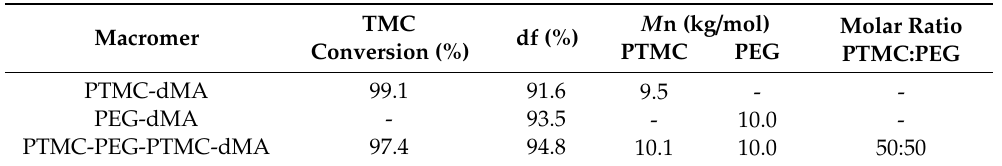
Table 1. Macromer properties. TMC conversion and number average molar masses ( M n) for PTMC-containing macromers and degree of functionalization (df) of all macromers as determined by 1 H-NMR. The M n for PEG as was provided by the